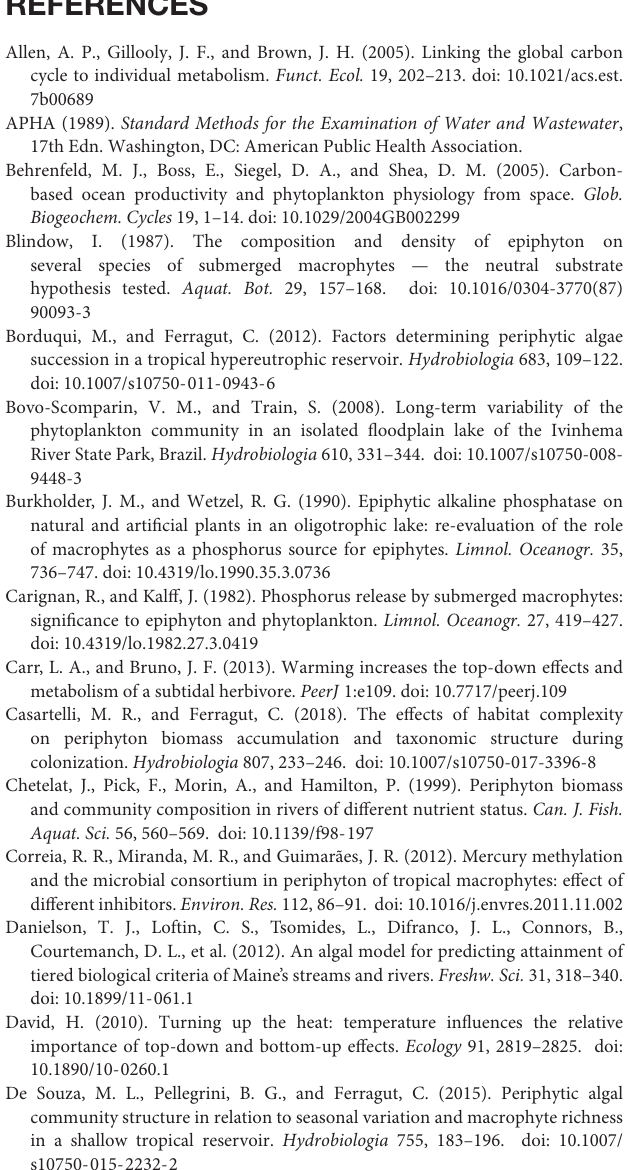
TABLE S2 | Results of three-way ANOVA comparing the effects of nutrient (two levels: low and high), temperature (three levels: ambient, warming and enhanced warming), nutrient*temperature and plant type (four levels: natural P. crispus , artificial P. crispus , natural E. canadensis and artificial E. canadensis ) on the relative abundance of Bacillariophyta, Chlorophyta and Cyanophyta in periphyton. All bolded values in the tables are significant at p < 0.05. TABLE S3 | Results of Pair-wise ANOSIM tests for treatment effects (nutrient*temperature) in May, August, November and February. CON represents ambient temperature without nutrient addition; W represents warming without nutrient addition; EW represents enhanced warming without nutrient addition; NP represents ambient temperature with nutrient addition; W&NP represents warming with nutrient addition; EW&NP represents enhanced warming with nutrient addition. All bolded values in the tables are significant at p < 0.05. TABLE S4 | Results of three-way ANOVA comparing the effects of nutrient (two levels: low and high), temperature (three levels: ambient, warming and enhanced